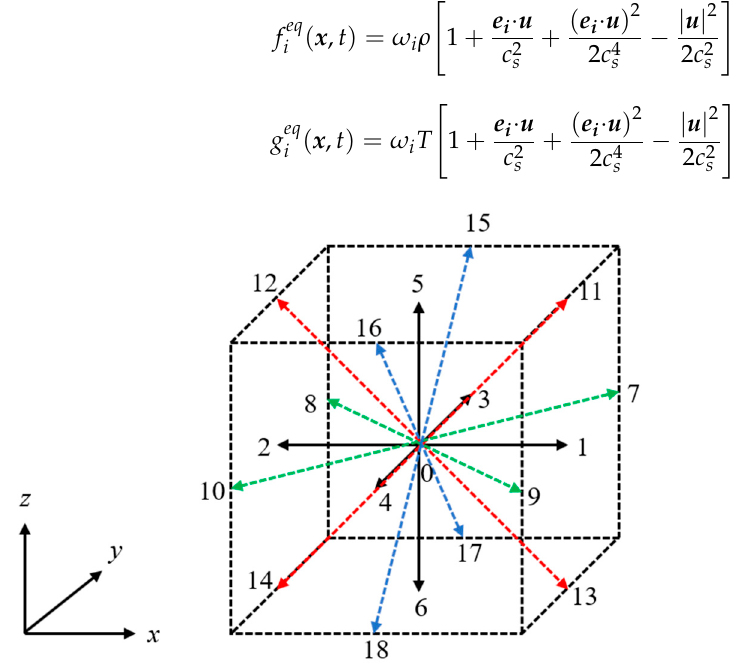
Figure 2. D3Q19 discrete velocity model.